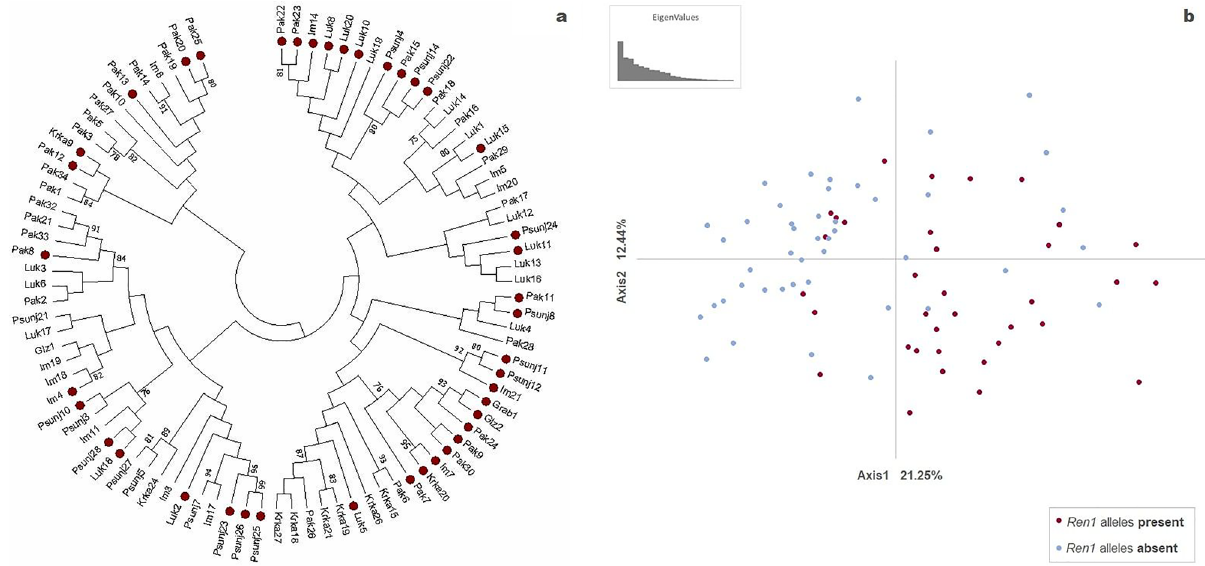
Figure 3. Clustering of 91 wild grapevine individuals based on three SSR markers at the Ren1 locus. ( a) Neighbor-joining dendrogram showing genetic relationships among individuals with bootstrap support value ≥ 75%. The samples with resistance alleles are marked with red dots. Analyses were conducted in MEGA7 21 . ( b) Principal coordinate (PCoA) projections of individuals in a 2-D plot based on genotypic distances conducted in GenAlex 22